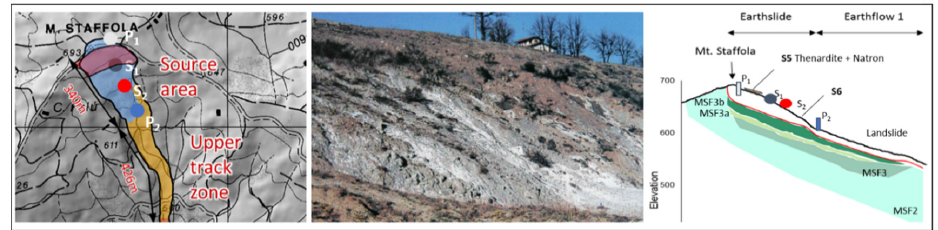
Figure 3. On the right, detail of the groundwater monitoring points in the source and earthslide1 zones (S1 and S2: springs; P1 and P2: piezometers) together with the area in which the thick white crusts (in purple) outcrop. In the middle, a photo taken in August 2015 in which the white powder is clearly visible together with the spring S2. Simplified geological cross section of the source and earthslide1 zone along with the groundwater monitoring points (P1, P2, S1, and S2) and soil samples S5 and S6.